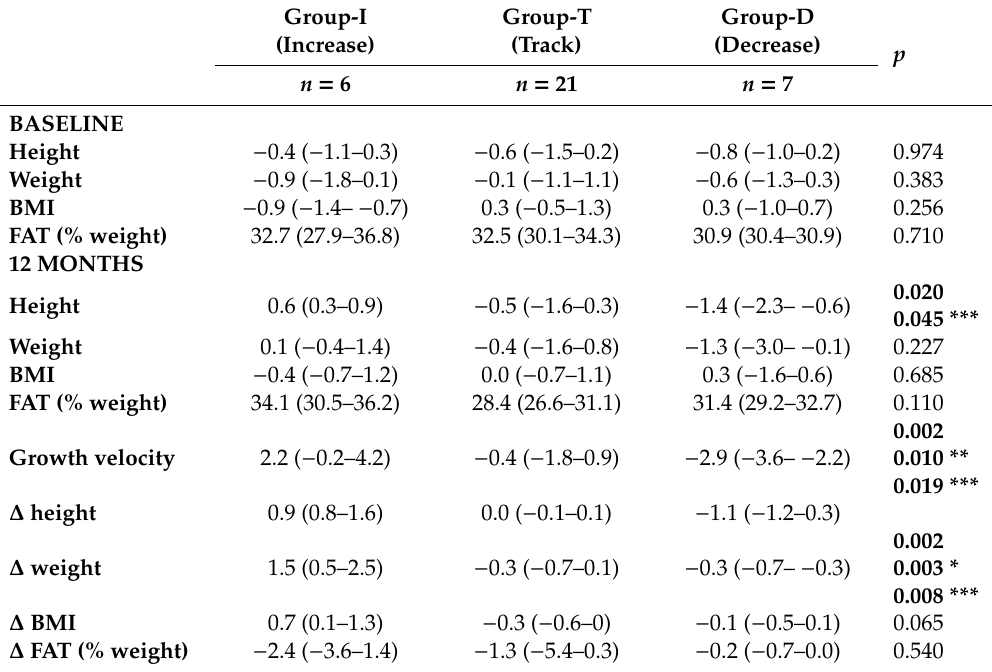
Table 5. Comparison between anthropometric and growth pattern characteristics (given as z-scores) of the three growth groups at baseline and after 12 months of ketogenic